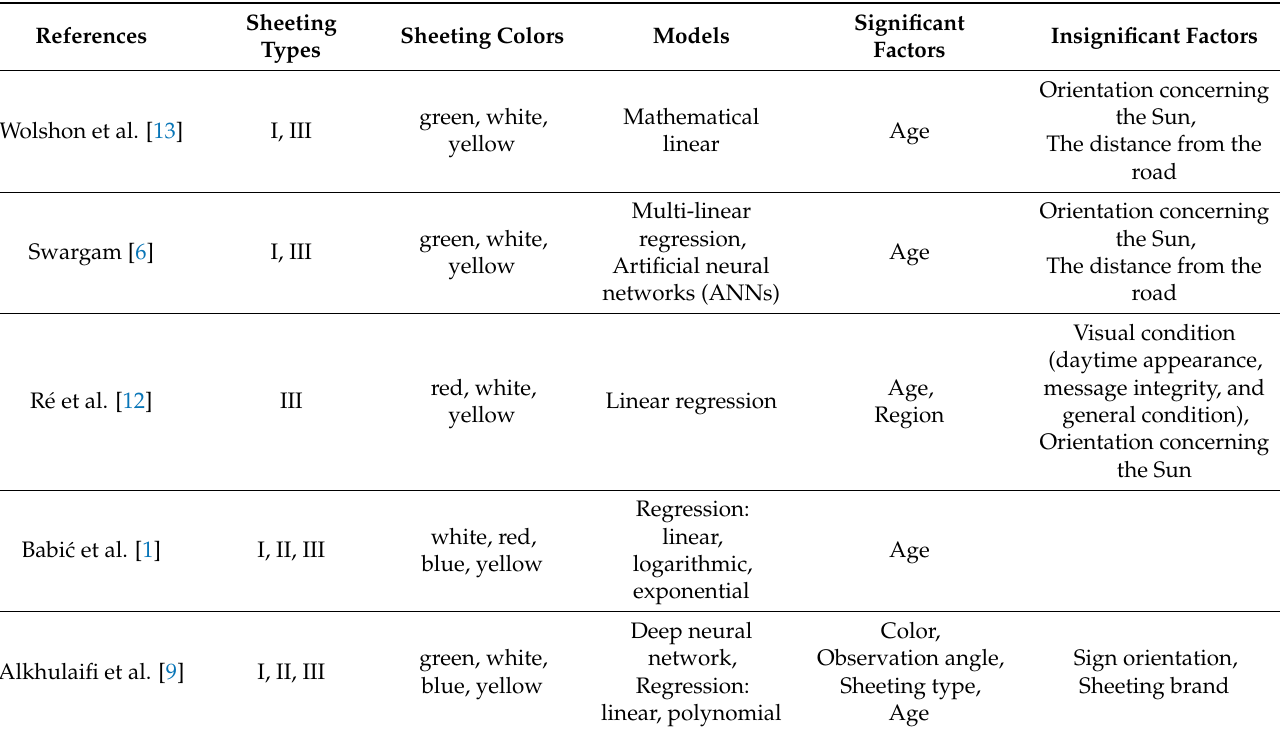
Table 1. Summary of the previous literature discussing retroreflectivity